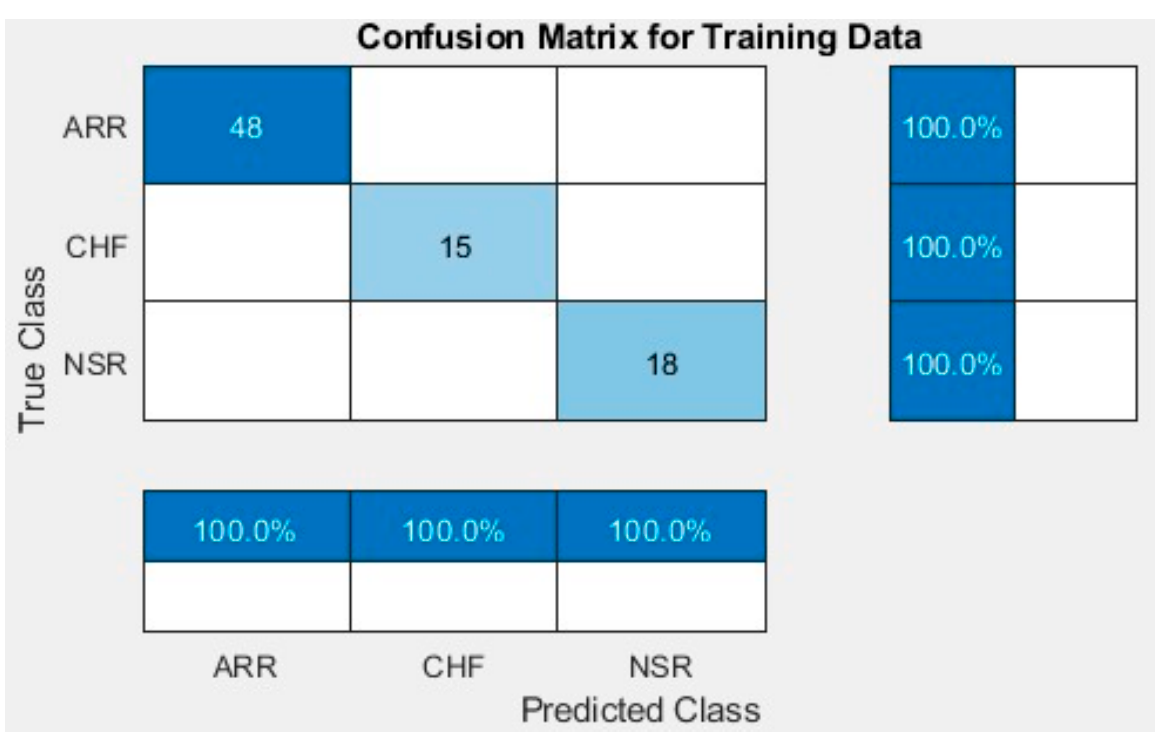
Figure 14. Confusion matrix for the validation set of the proposed hybrid BA-CNN-LSTM algo- rithm.